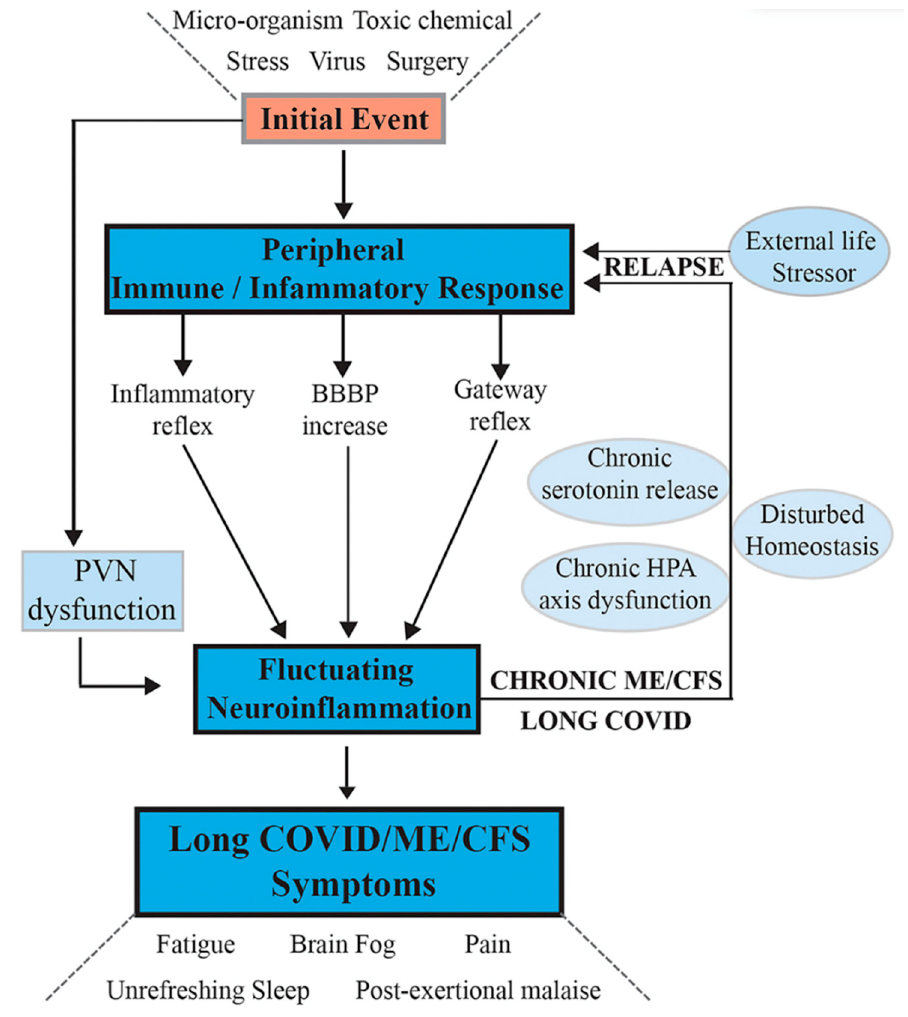
Figure 6. Hypothesis and model for onset of ME/CFS and its progression to a chronic sustained illness with relapse/partial recovery phases. Signaling pathways between the CNS and the periphery that maintain the illness. Following an initial external stressor event, systemic immune/inflammatory responses are activated. These are communicated to the CNS via inflammatory and gateway reflexes and possibly an increase in permeability of the BBB. Neuroinflammation is activated affecting the stress center within the PVN of the hypothalamus and leads to a wide range of neurological symptoms that feedback to the periphery via disturbance of homeostasis, and the stress-activated HPA axis that becomes dysfunctional with chronic activation. The systemic physiology and molec- ular homeostasis are then chronically affected through important cellular functions, such as mito- chondrial energy production, metabolic activity, and a continuation of immune/inflammatory reac- tions. External life stressors that feed into a disturbed PVN not only maintain the ME/CFS but also act to precipitate relapses. Reproduced from [5] with permission.